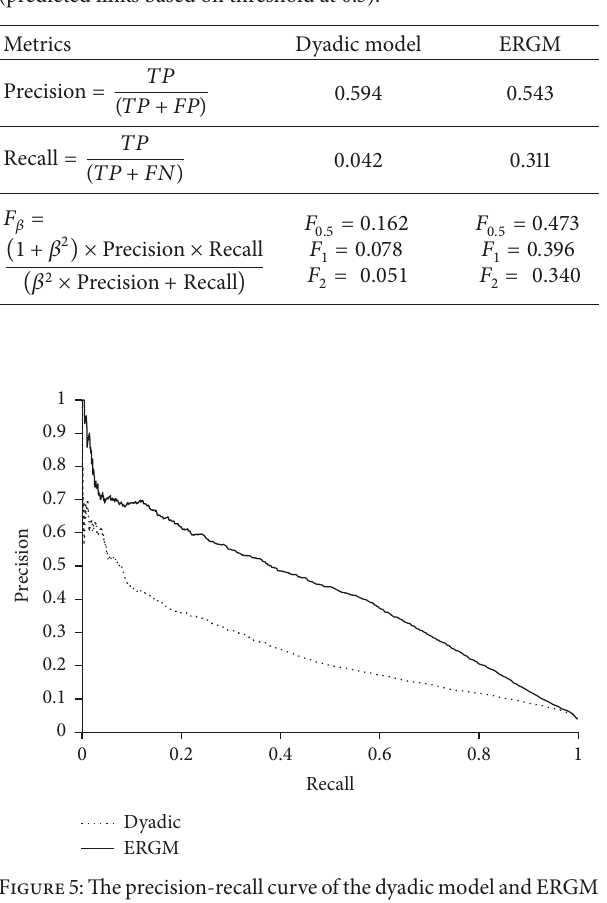
Figure 5: Theprecision-recall curve of thedyadic model and ERGM with random network benchmarked.